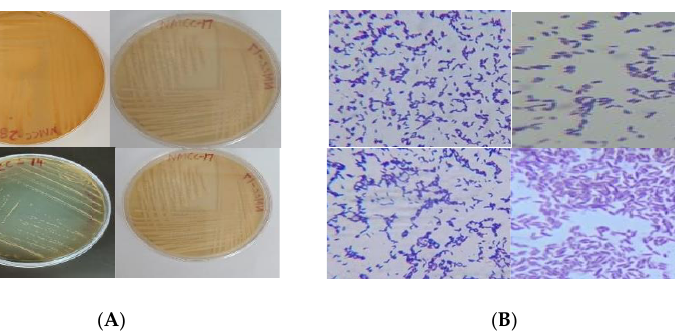
Figure 1. ( A ) Colony morphology; ( B ) Gram staining of the isolated probiotics strains. Microorganisms 2022 , 10 , x FOR PEER REVIEW